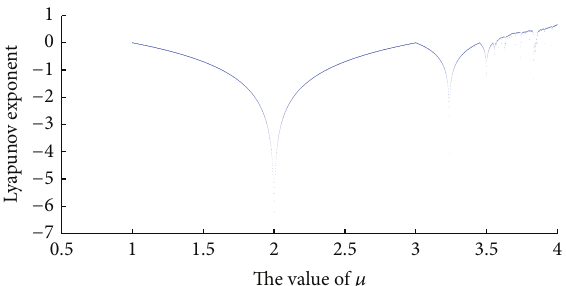
Figure 2: Lyapunov exponent spectrum of Logistic Map.